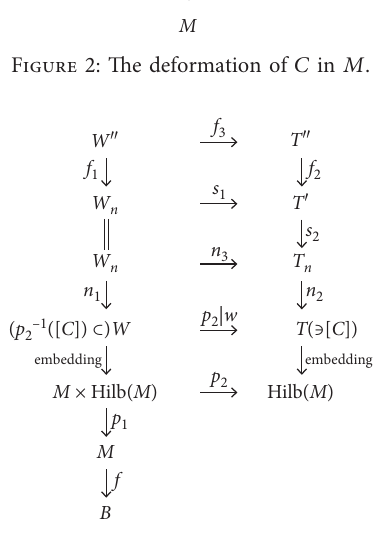
Figure 3: The flattening of the